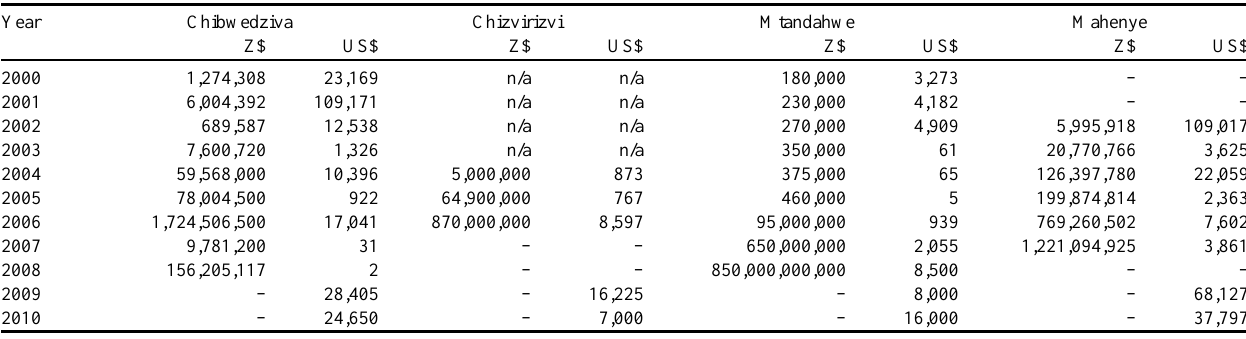
Table 7 . Revenue received by Chibwedziva, Chizvirizvi, Mahenye, and Mtandahwe CAMPFIRE communities from the Rural District Councils and safari operator between 2000 and 2010. Source: Chiredzi Rural District Council, Mahenye and Mtandahwe CAMPFIRE committees, and Lowveld Hunters databases. Z$: Zimbabwean dollar; US$: United States dollar; n/a: not applicable; –: unavailable. Revenue (US$) is based on the official exchange rates from Wikipedia (http://en.wikipedia.org/wiki/ Zimbabwean_dollar). The Zimbabwean dollar was abandoned as an official currency in